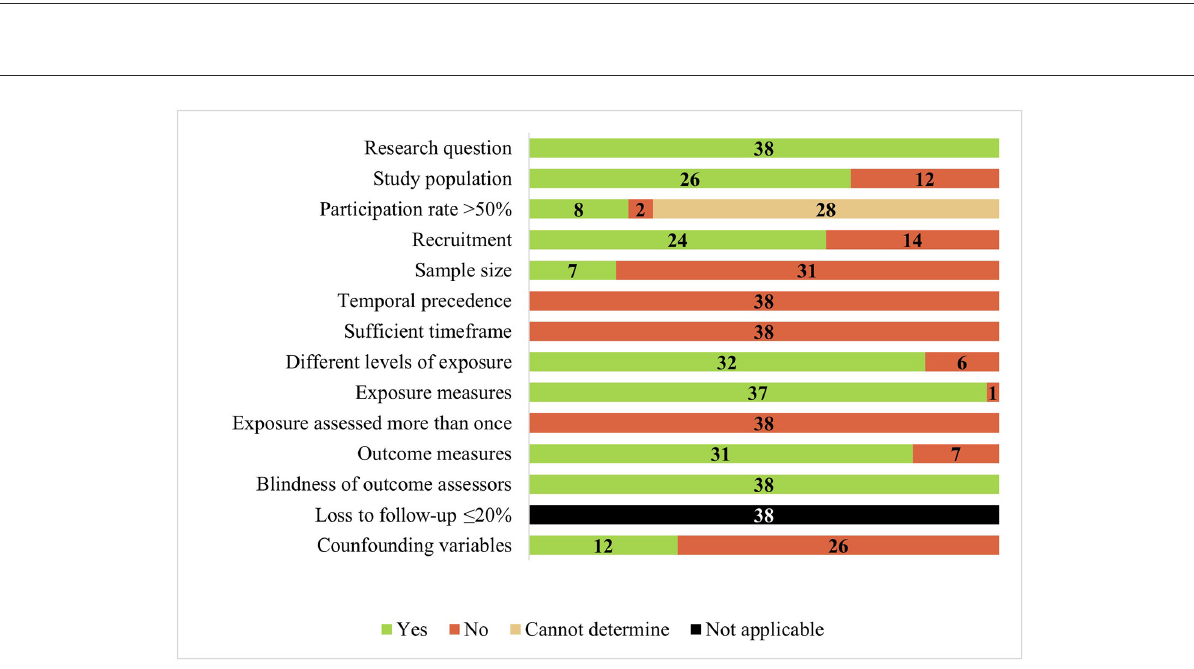
FIGURE2 Quality assessment using national institutes of health’s tool for observational cohort and cross-sectional studies ( n =